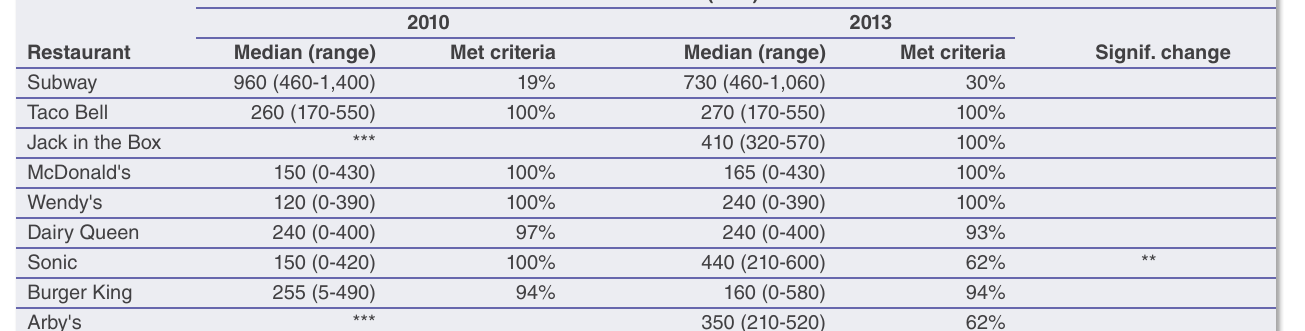
Met criteria Signif.